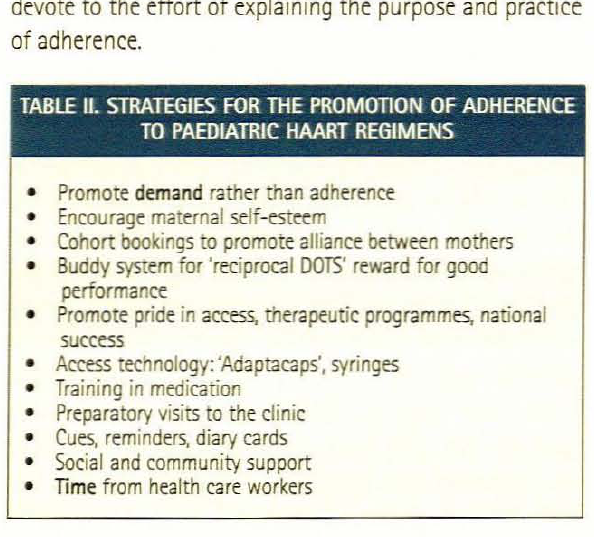
TABLE 11. STRATEGIES FOR THE PROMOTION OF ADHERENCE TO PAEDIATRIC HAART